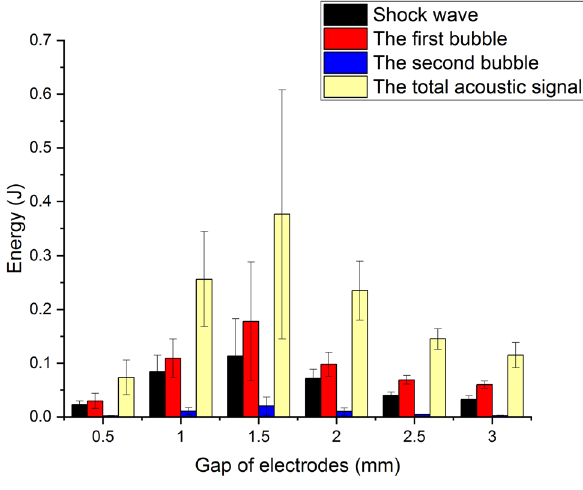
Figure 5. The energy versus